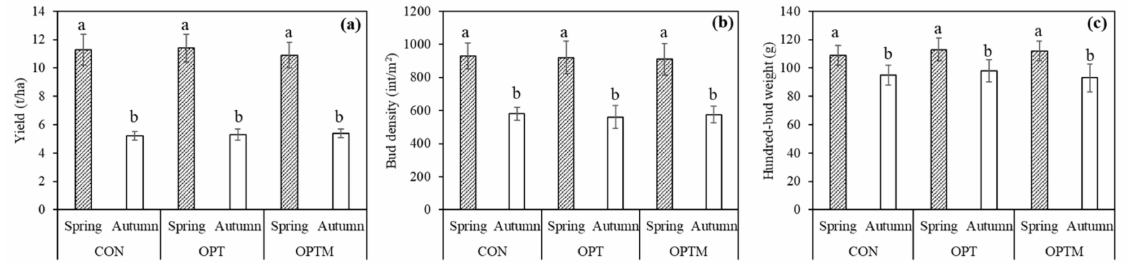
Figure 1. The yield ( a ), bud density ( b ) and hundred bud weight ( c ) of oolong tea in spring and autumn of 2019. Different letters indicated significant differences between mean values ( p < 0.05). CON, conventional fertilization; OPT, optimized fertilization; OPTM, optimized fertilization supplemented with Mg.